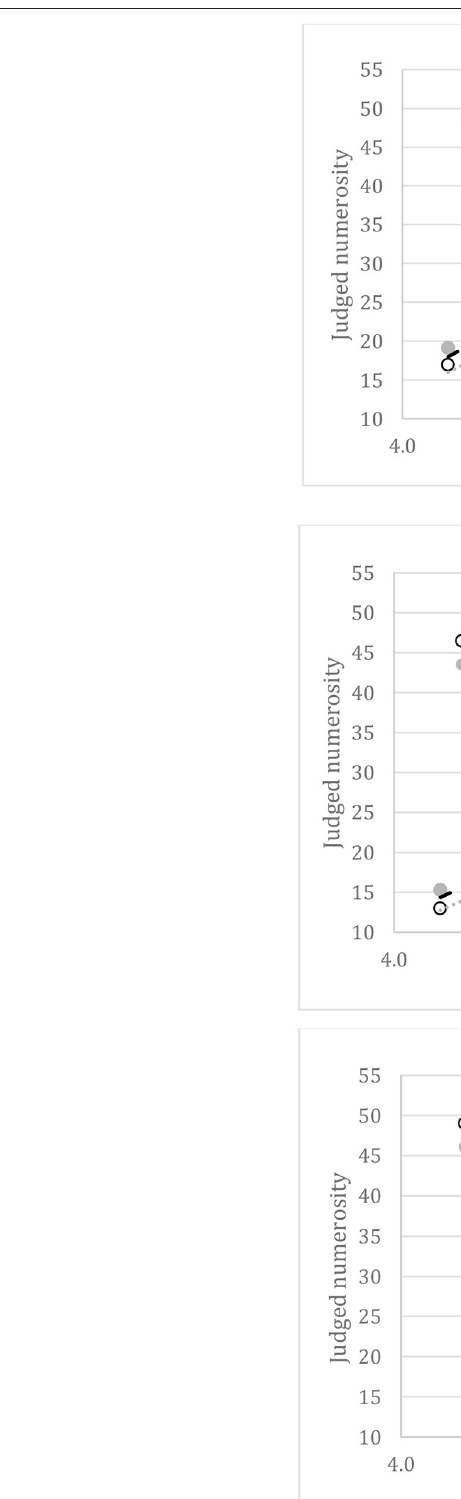
Frontiers in Human Neuroscience |